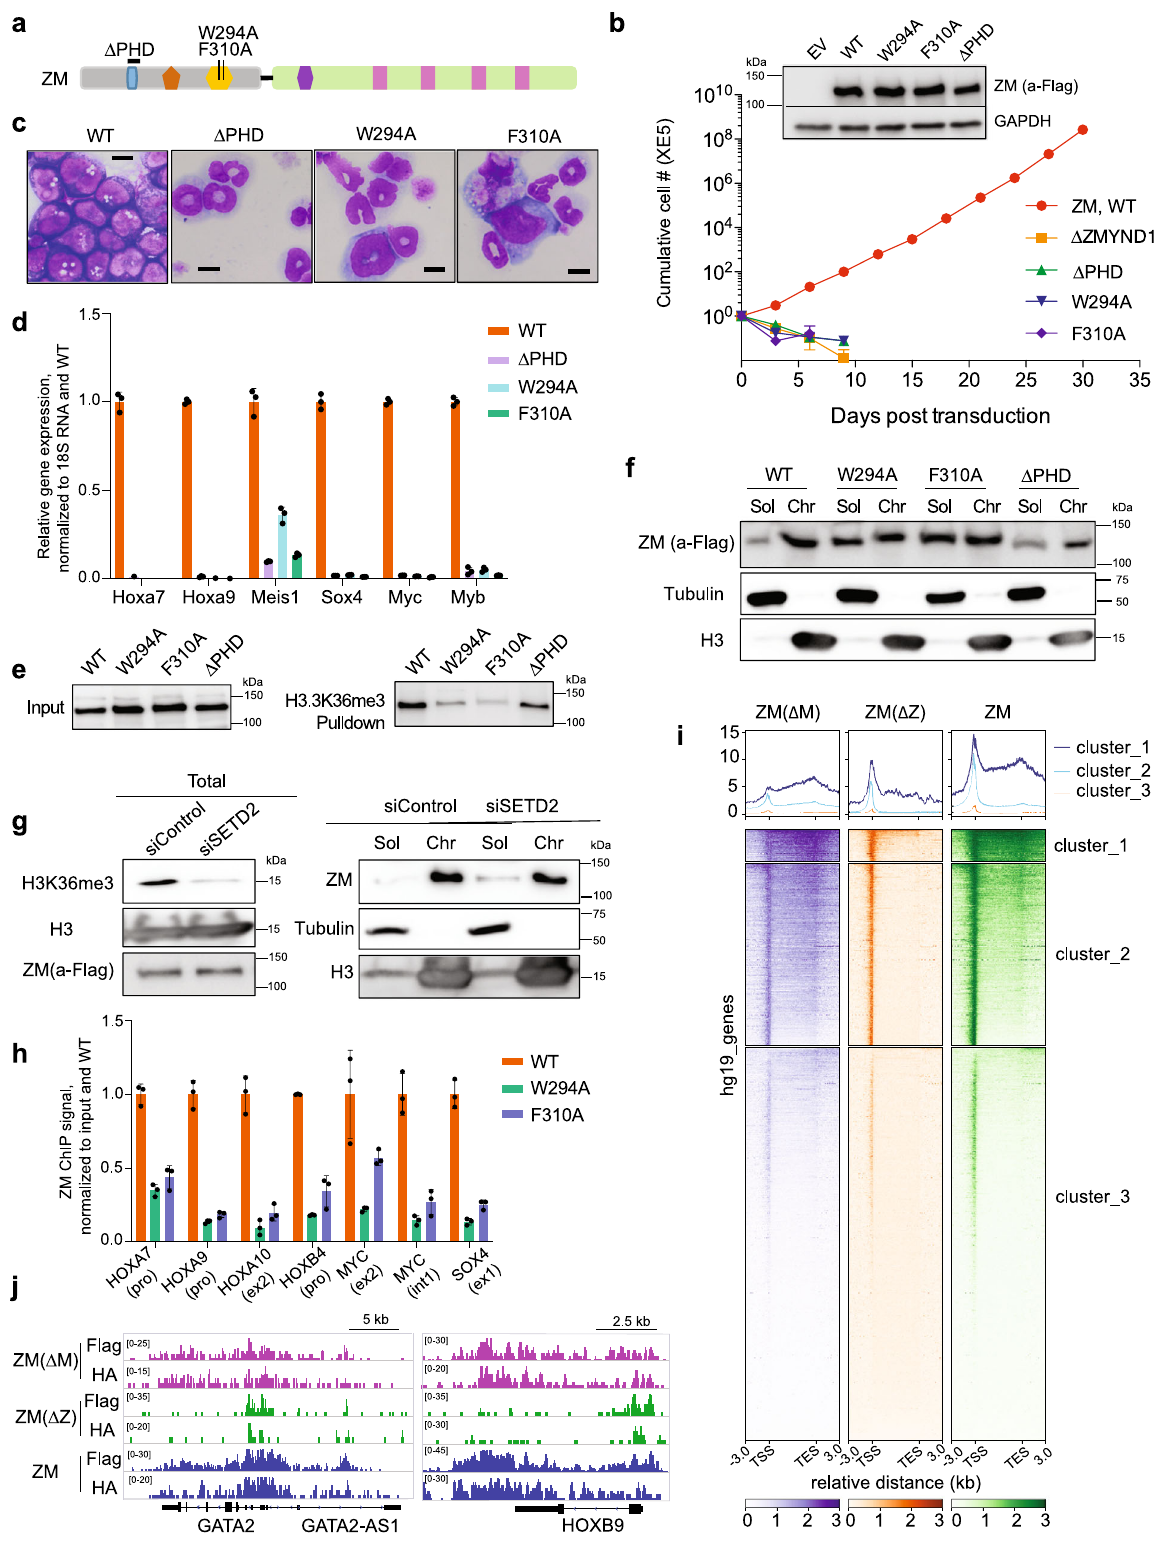
and that of ZM Δ M, relative to ZM Δ Z, suggesting that the ZMYND11 segment plays a major role in ZM ’ s chromatin tar- geting (Supplementary Fig. 7c). Together, chromatin targeting of ZM is modulated by both ZMYND11 segment (for binding location and af fi nity) and MBTD1 segment (for binding location), with the former one being the major